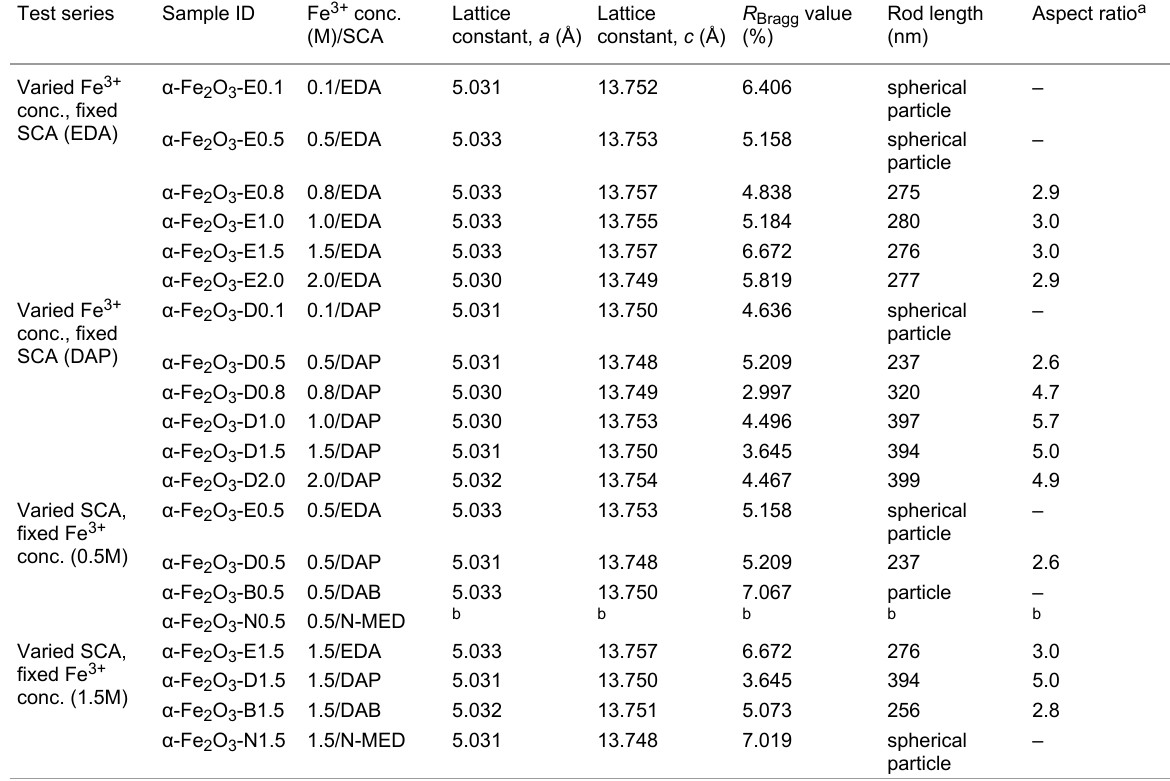
Table 1: Physicochemical characteristics of α -Fe 2 O 3 synthesized with different SCAs and various Fe 3+ concentrations. DAP: 1,2-diaminopropane, EDA: ethylenediamine, DAB: 2,3-diaminobutane, N-MED: N -methylethylenediamine. Test